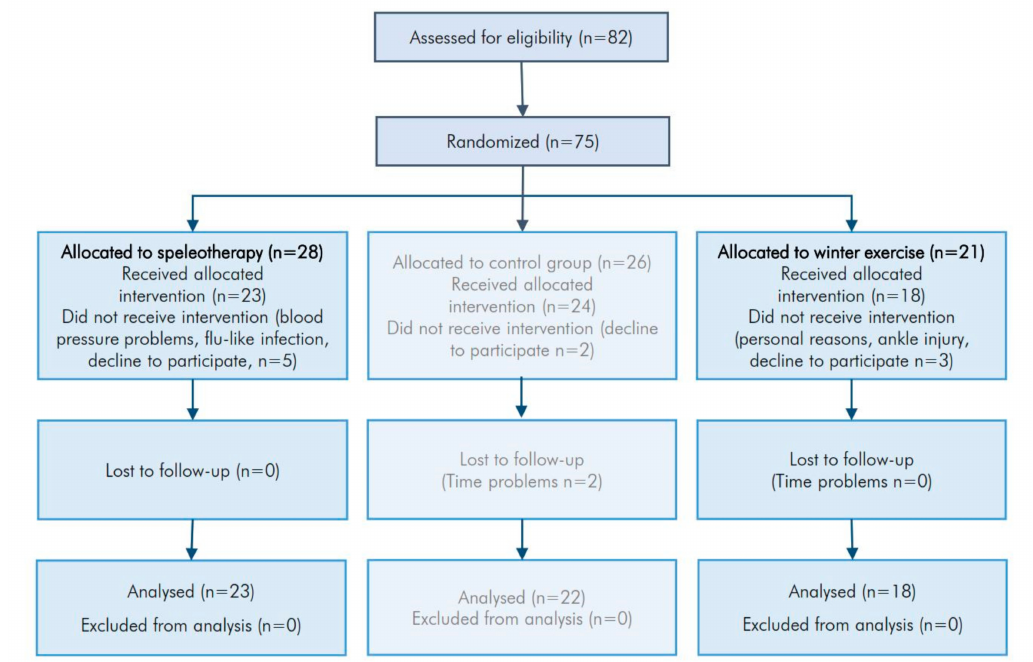
Figure 2. Study flowchart of included and excluded